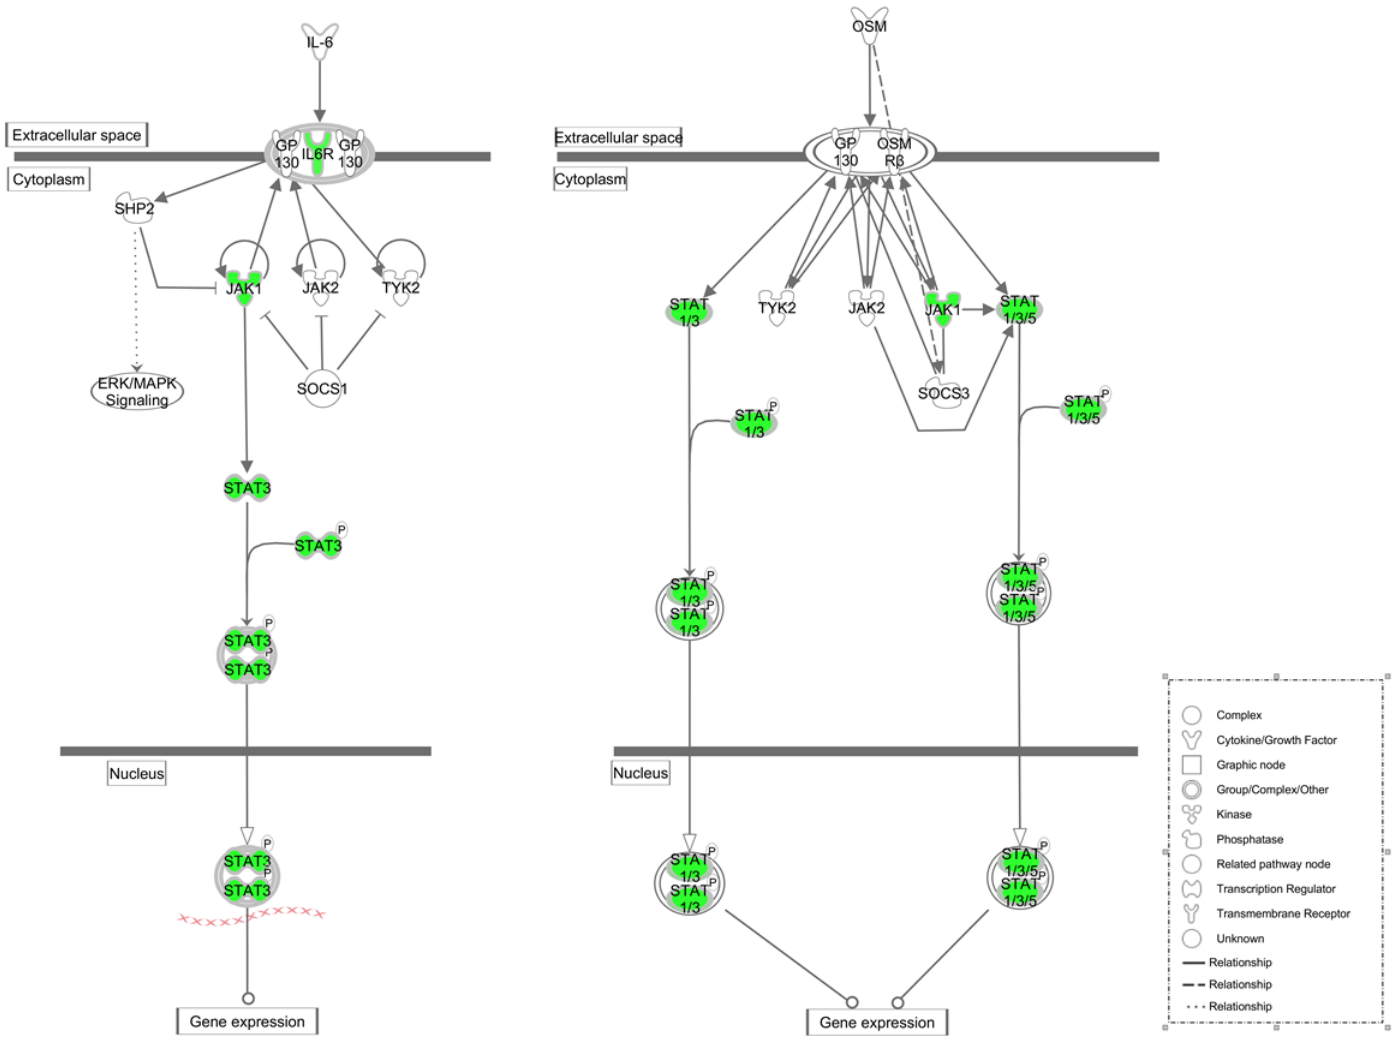
Figure 5. Schematic diagram of IL-6 and OSM signaling pathways in the anti-osteopenic effects of RDE: Down-regulated genes are in green. Genes in white were not specified but were used to establish network based on